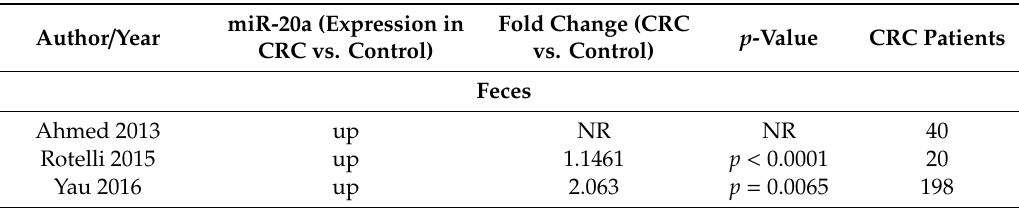
Table 2. miR-20a expression in colorectal cancer (CRC) versus controls. Up, higher expression in CRC; down, lower expression in CRC; NR, not